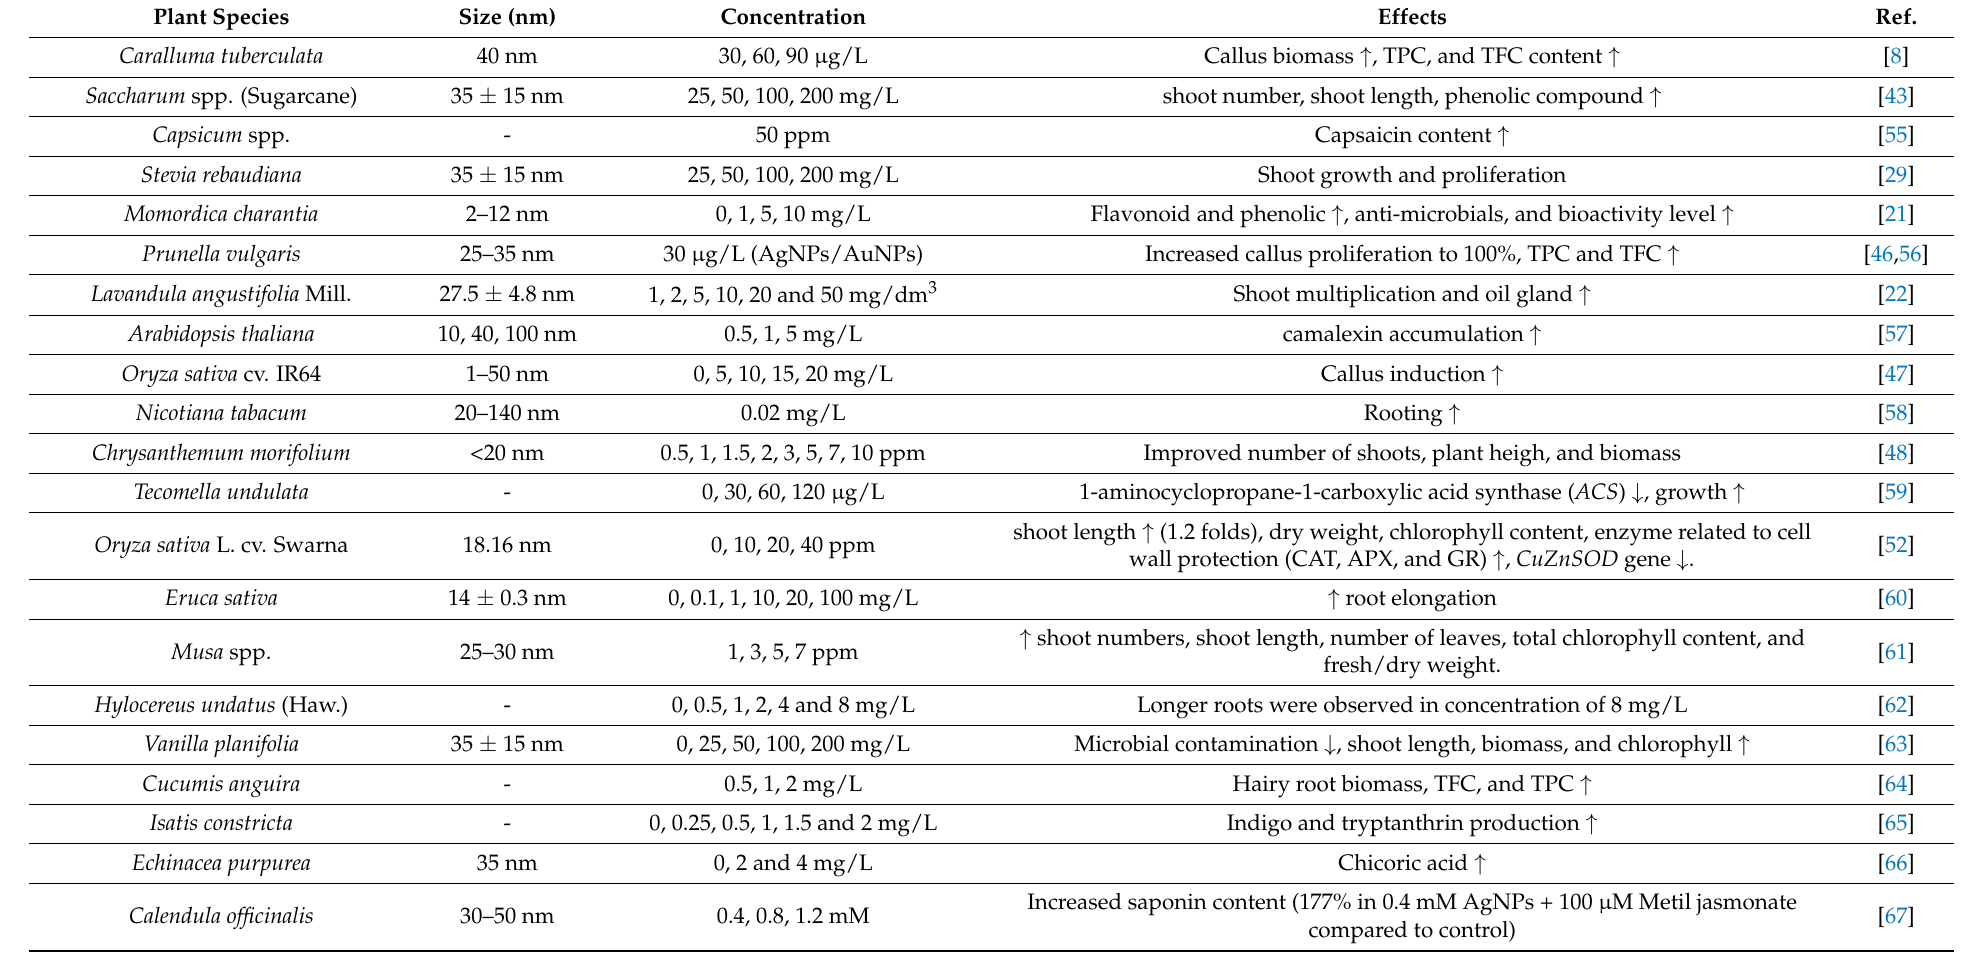
Table 1. Recent studies in AgNPs-mediated elicitation which result in Crop Improvement and Secondary Metabolites